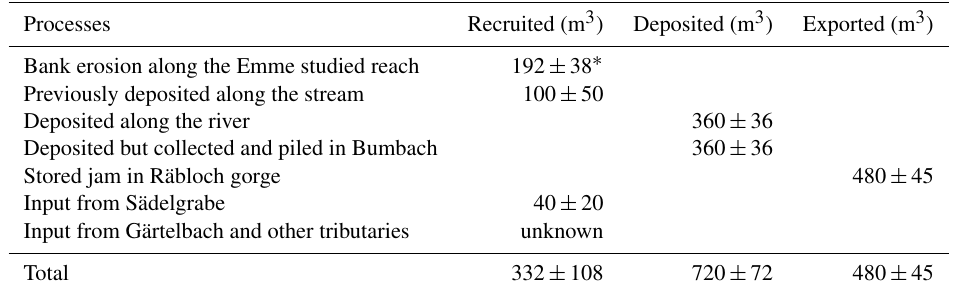
Table 5. Wood budget along the lower reach of the studied Emme River segment (reach between 1.25km downstream of the Bärselbach stream and the Räbloch; Fig. 1). Uncertainties are included in the stated